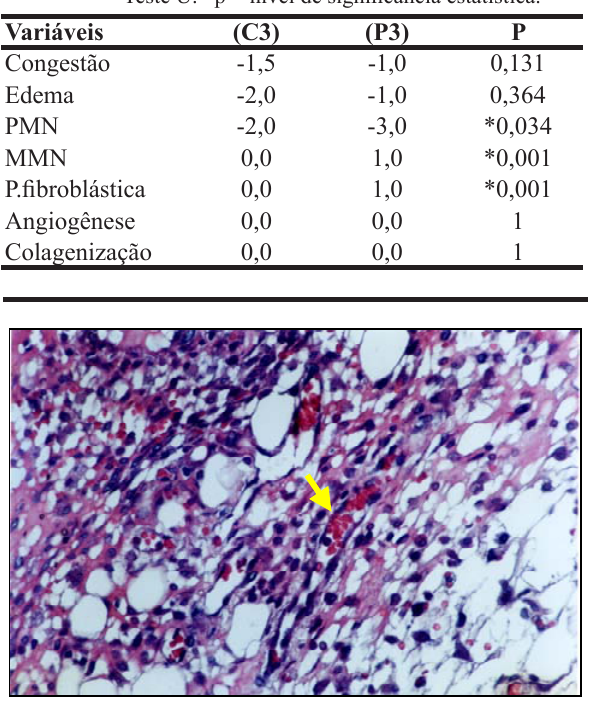
FIGURA 5 – Fotomicrografia de congestão vascular e edema, animal controle três dias. HE, 400 x